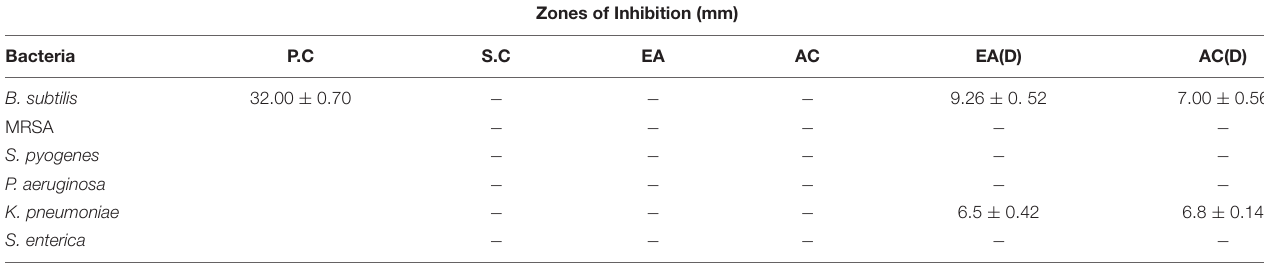
Zones of Inhibition (mm)